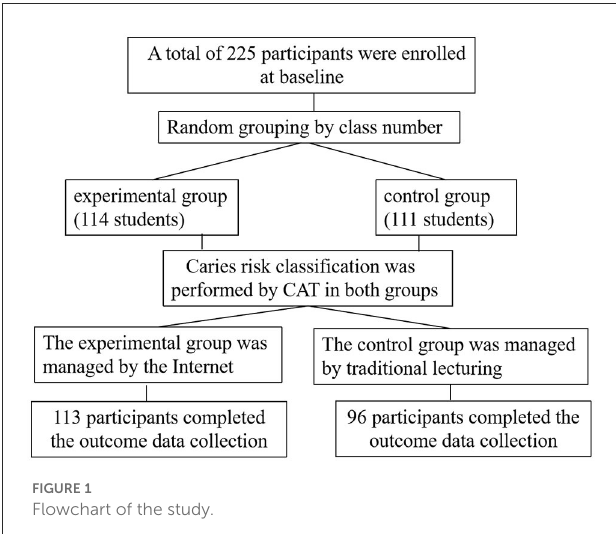
FIGURE1 Flowchart of the